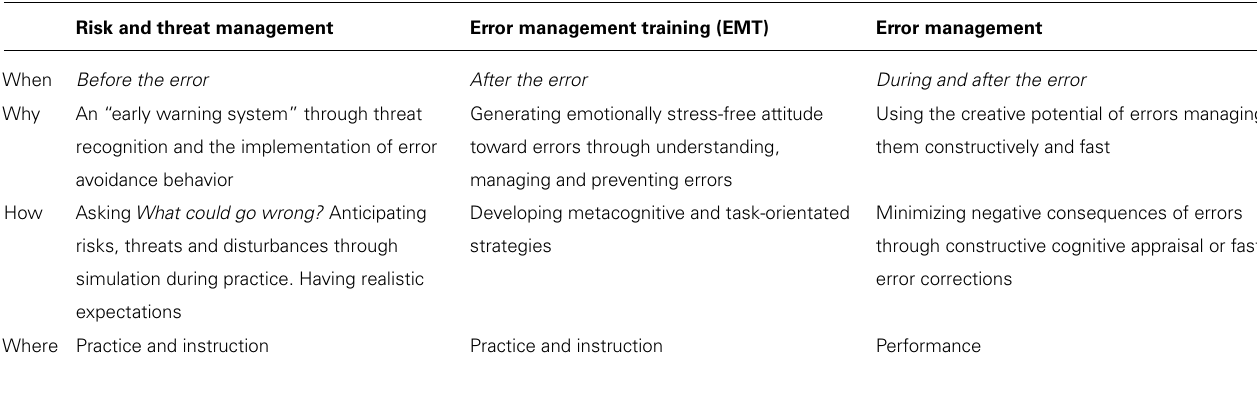
Table 1 |Approaches to error management